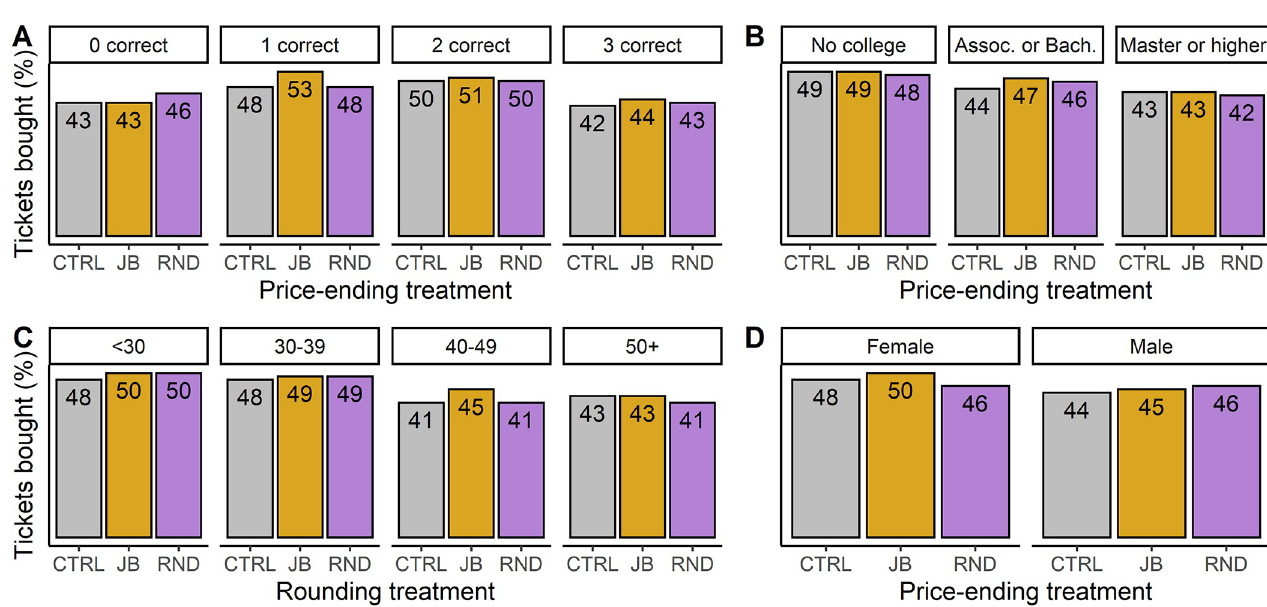
Fig 3. Purchasing rates across the exploratory variables. A: purchasing rates divided per numerical ability–i.e., the number of questions the participant correctly answered during the incentivized part of the questionnaire. B: purchasing rates subdivided by highest obtained educational degree. C: purchasing rates subdivided by participant’s age. D: purchasing rates by gender (the categories “other” and “do not wish to say” are not depicted due to low sample sizes). CTRL = control prices, JB = just-below prices, RND = rounded prices.